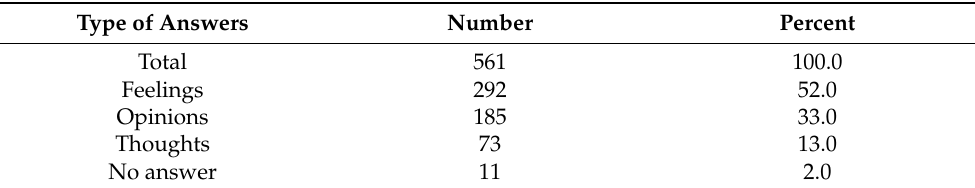
Table 5. Answers regarding the effect that the crisis has had on